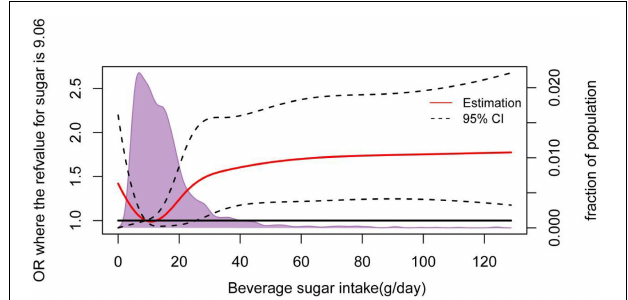
FIGURE 2 | An adjusted odds ratio for beverage sugar intake and overweight/obesity using restricted cubic spline (RCS) analysis. The RCS model adjusted for age, gender, and region. The solid red line is the multivariate adjusted hazard ratio, and the dashed line shows the 95% confidence interval from restricted cubic spline regression. The unassociated reference line is shown in solid bold based on the basic and beverage consumption data, gathered by the Shandong Center for Disease Control and Prevention from 2013 to 2016.